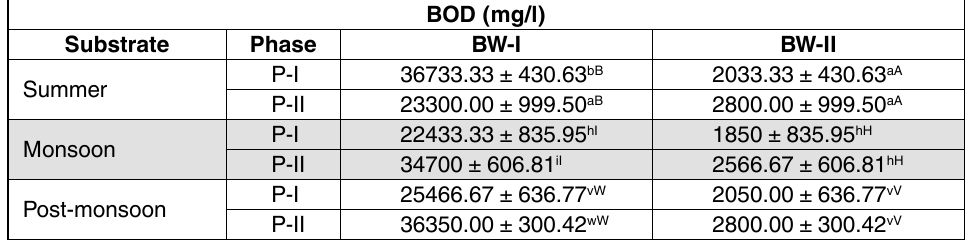
Table 3. Estimated BOD (mg/l) of poultry slaughter waste and food waste leachate